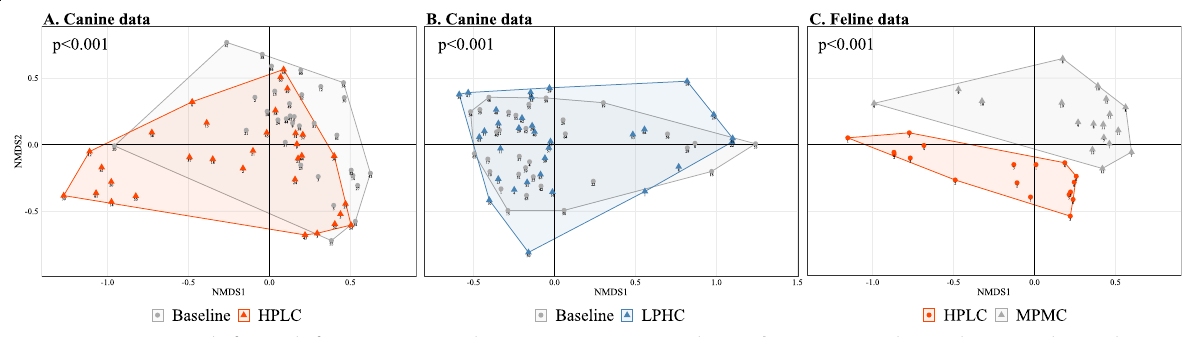
Fig. 3 ARG composition before and after intervention with HPLC (a , stress = 0.15 ) and LPHC (b , stress = 0.16 ) diets in the canine data, and between different HPLC and MPMC diet groups in the feline data (c , stress = 0.10 ) . In both data, there were statistically significant associations between diet type and ARG composition (all p < 0.001, permutational multivariate analysis of variance test)